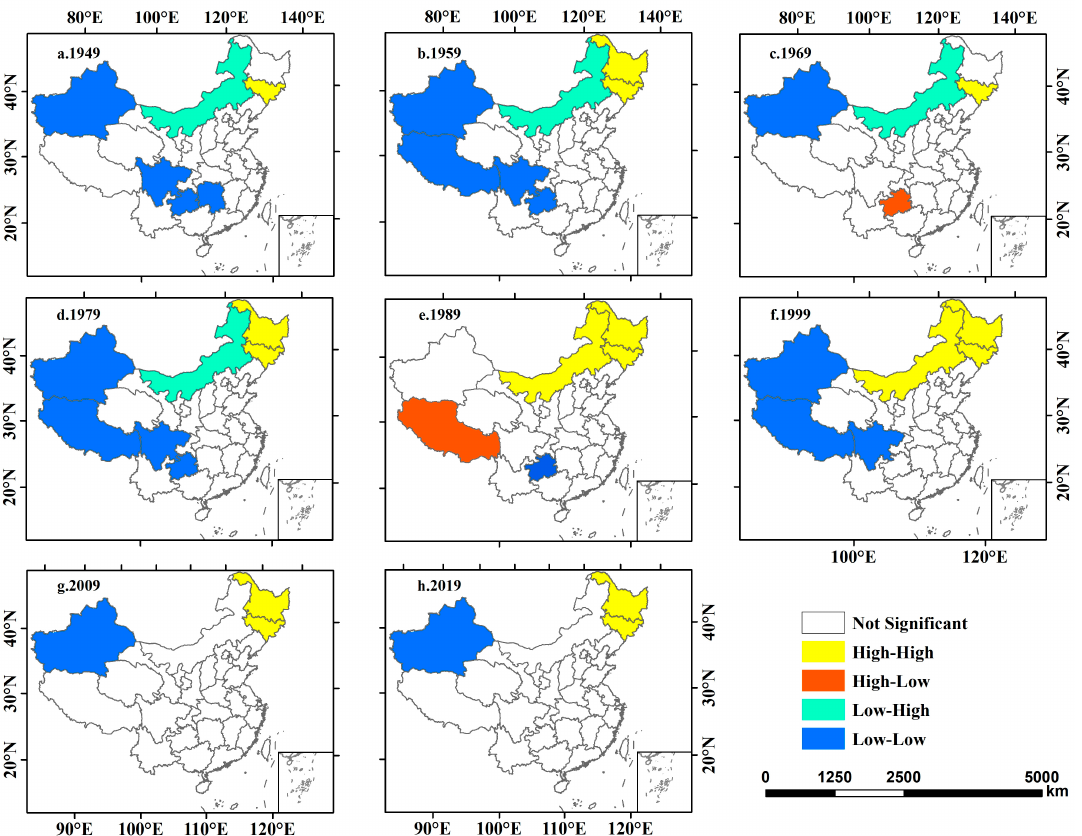
Figure 8. LISA aggregation map of the comparative advantages of soybean planting scale in China.